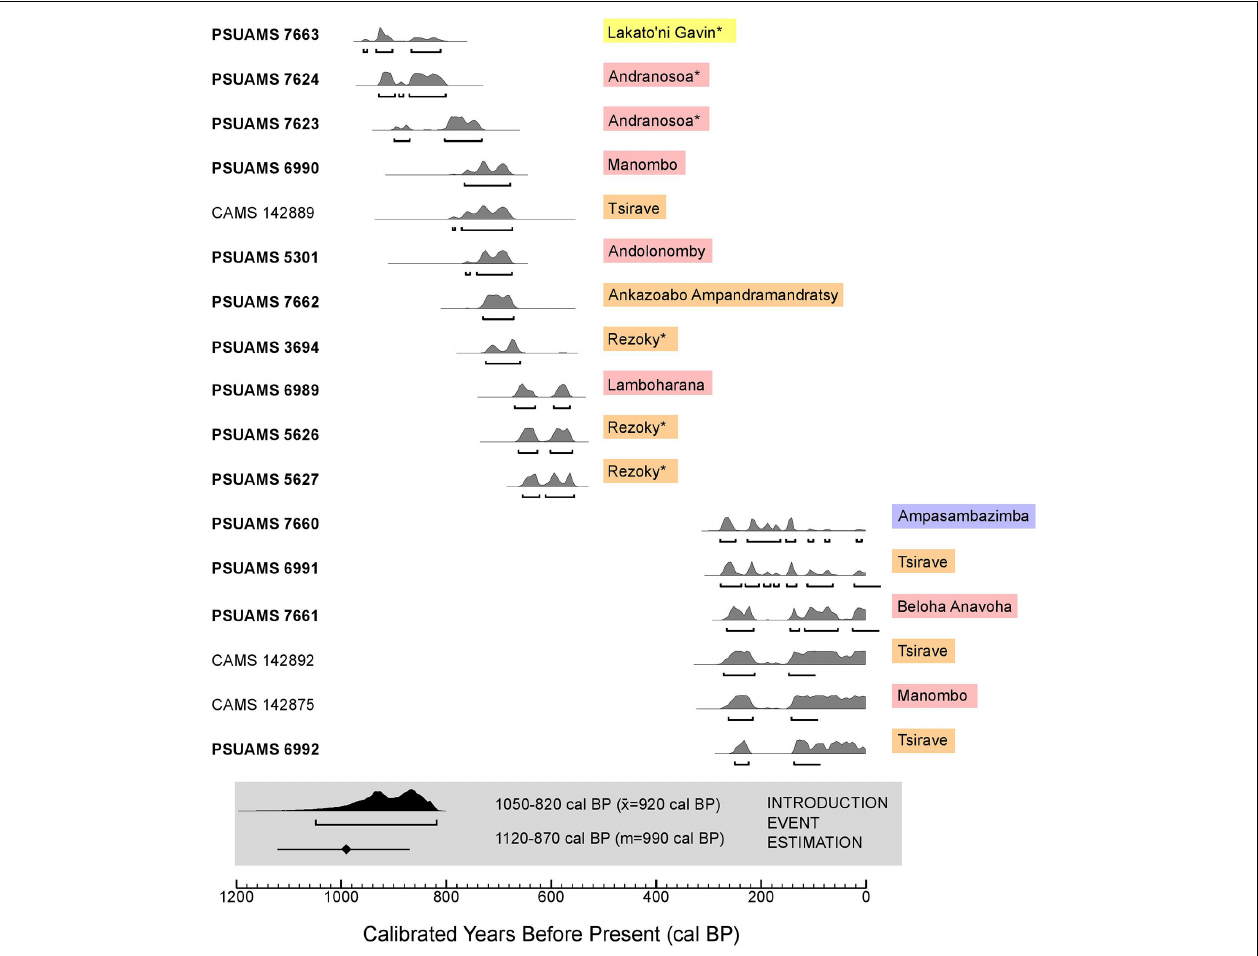
FIGURE 4 | Dog collagen 14 C dates calibrated in OxCal 4.4 with SHCal 20 (Hogg et al., 2020). Previously unpublished dates are bolded, sites are colored according to ecoregion (red = spiny thicket, orange = succulent woodland, blue = central highlands, yellow = dry deciduous forest), and archeological sites are marked with asterisks. Shaded box includes results from two approaches to introduction event estimation: The bracket under the Bayesian posterior probability distribution spans 95.5% of the distribution, and the diamond and associated line marks the median and 95% confidence interval estimate from the classical frequentist